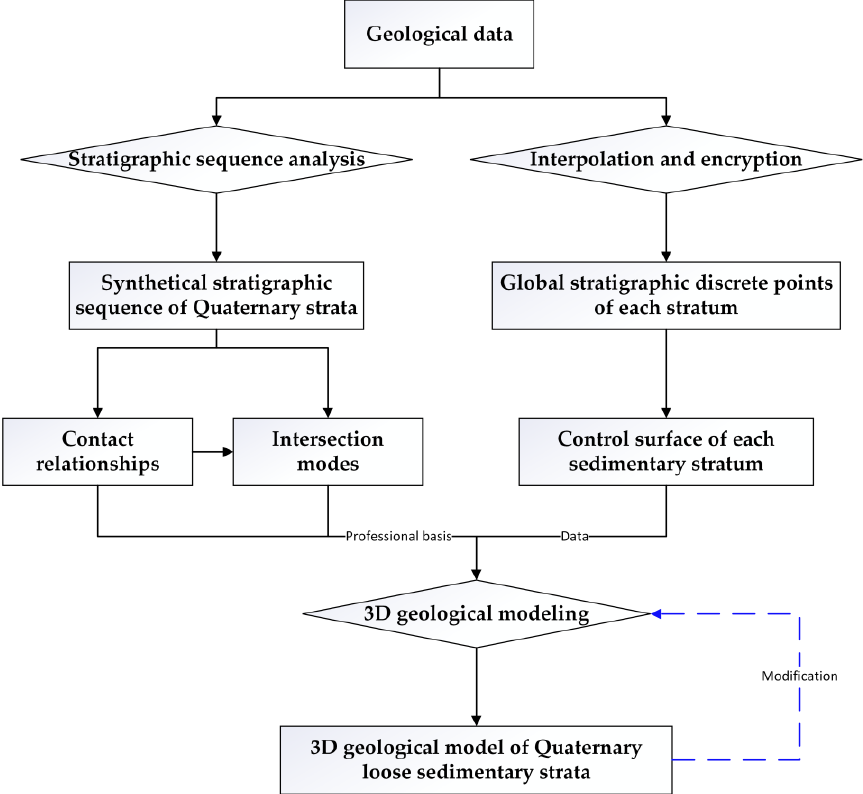
Figure 5. Technical scheme of construction of 3D geological model of Quaternary loose sedimentary strata based on the global stratigraphic discrete points.